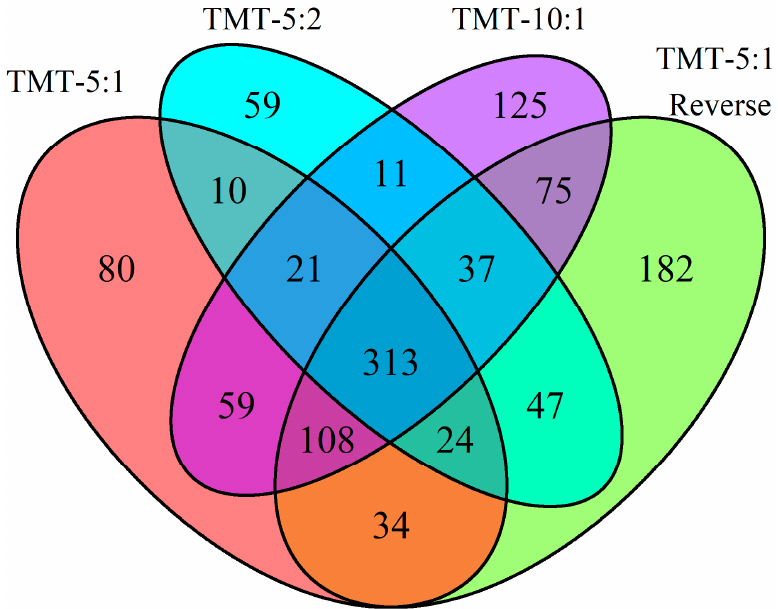
Figure 2. Venn diagram of proteins identified by each method from plasma samples. Protein IDs (see Supplementary Tables) were aligned and compared between methods.